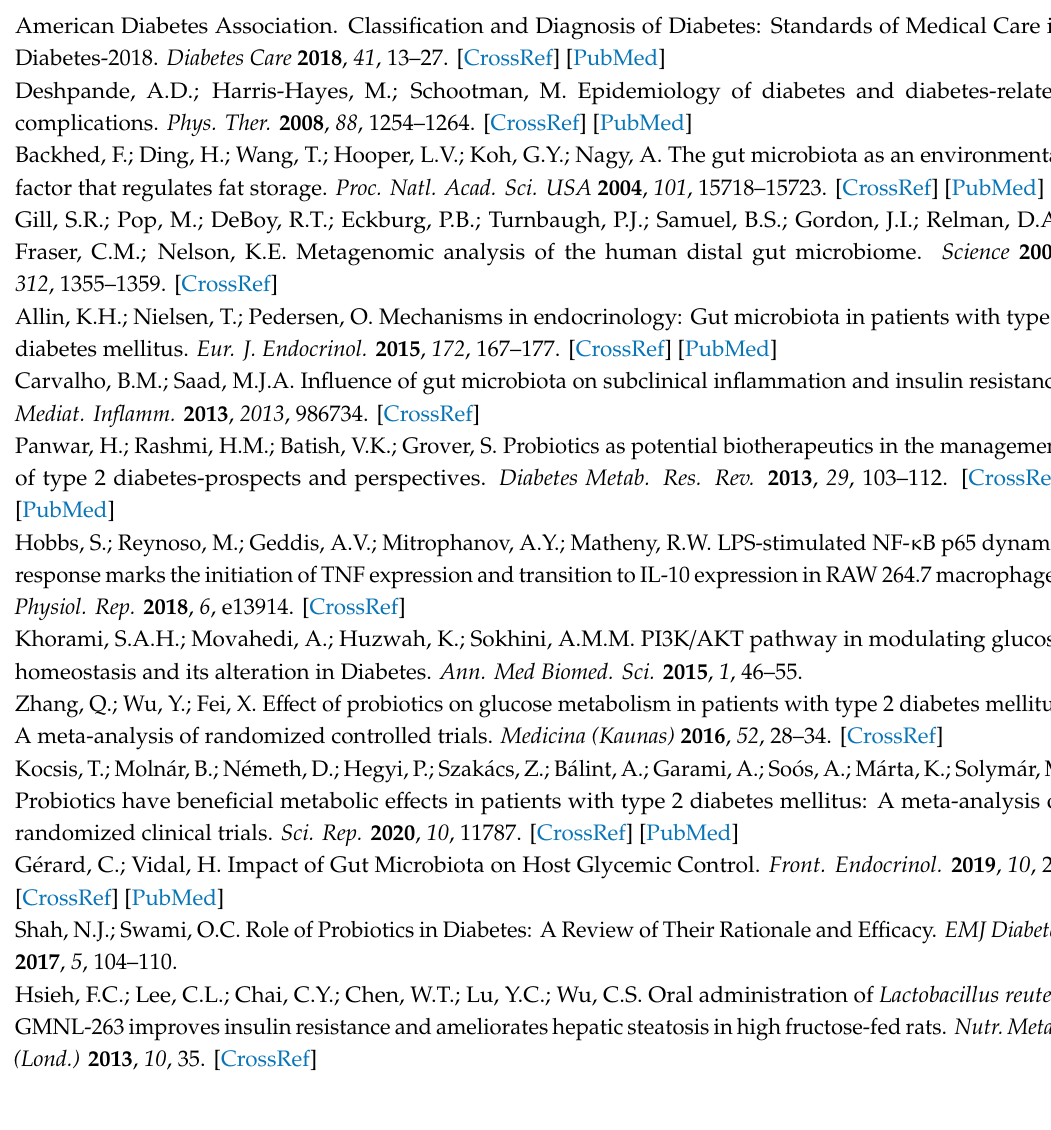
Table S1: The composition of normal and high-fat diet., Table S2: Group-specific primers of bacterial targets based on 16 S rDNA sequences., Table S3: E ff ects of L. paracasei HII01 on tissue TG accumulation in experimental groups., Figure S1: E ff ects of L. paracasei HII01 on in vitro glucose uptake in experimental groups., Figure S2: E ff ects of L. paracasei HII01 on cecal SCFAs of the experimental groups., Figure S3: E ff ects of L. paracasei HII01 on the mean percent change in bacterial abundance from baseline analyzed in feces of the experimental